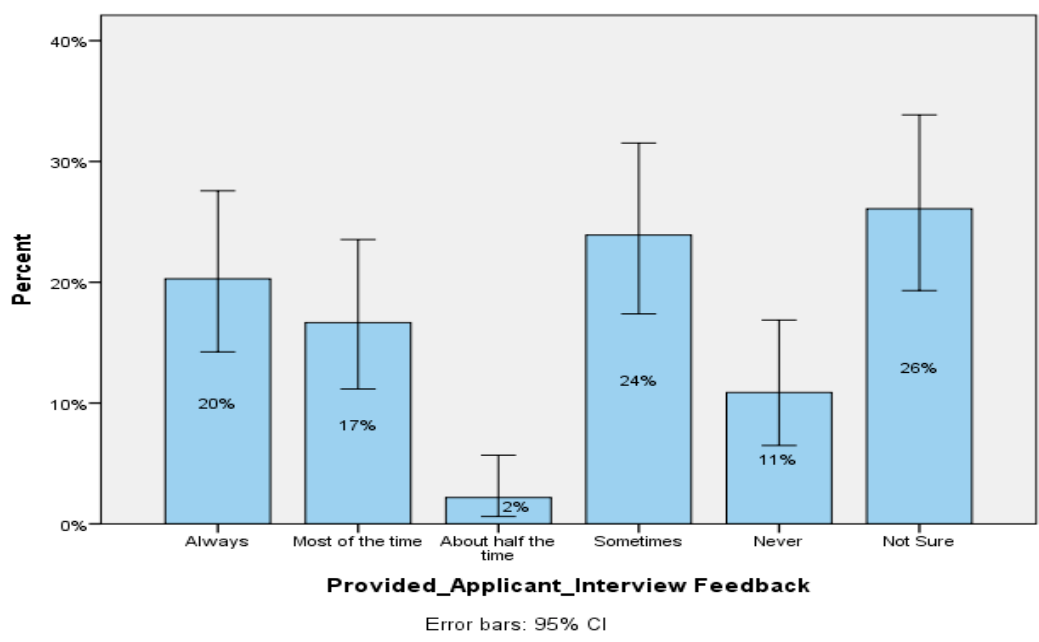
Figure 8. Interview feedback to all applicants.